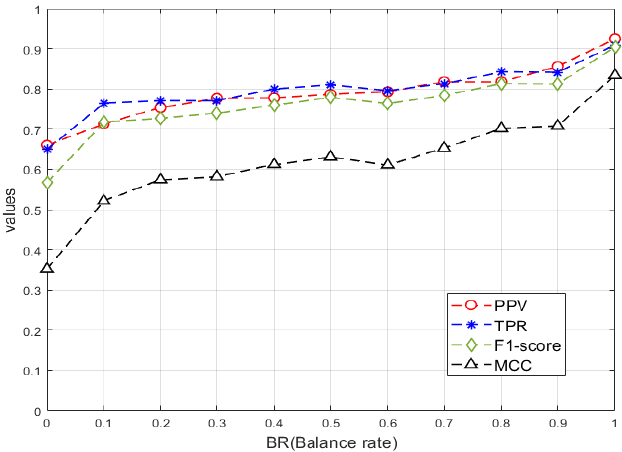
Figure 4. Performance metrics values over BR.